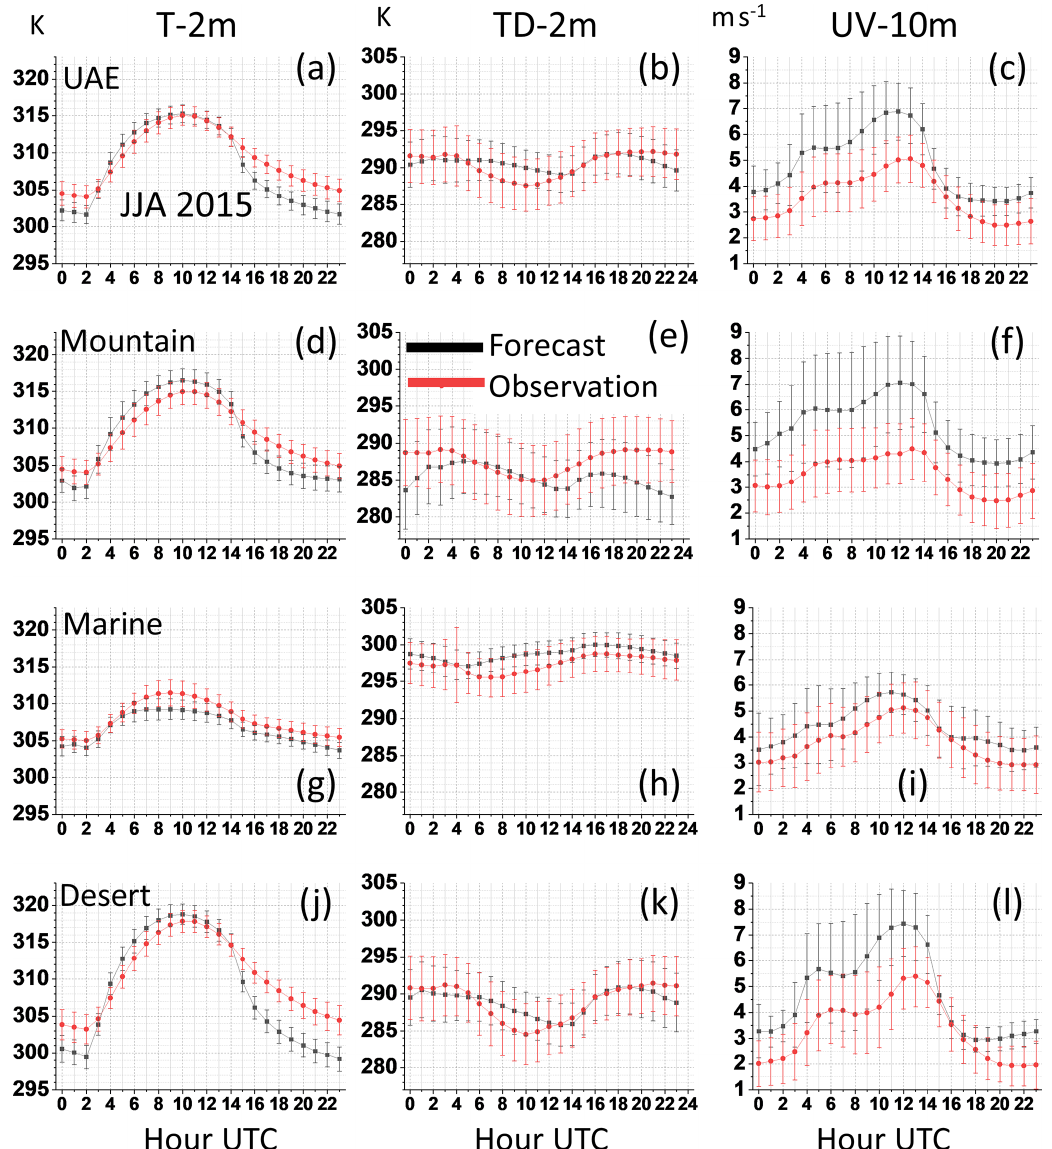
Figure 9. Summer diurnal cycles. As for Fig. 8 except for the period June–August